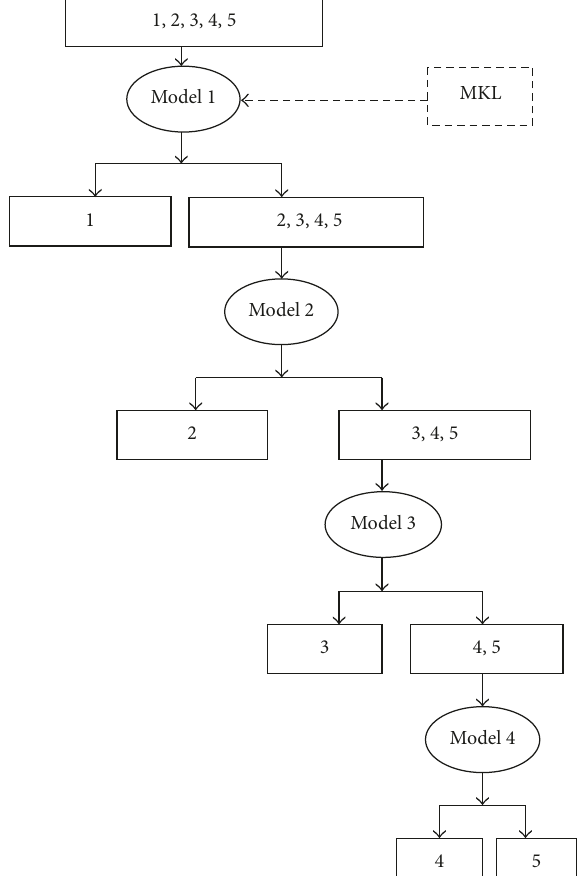
Figure 2: The binary-tree structured multiclass and multiple-kernel SVM